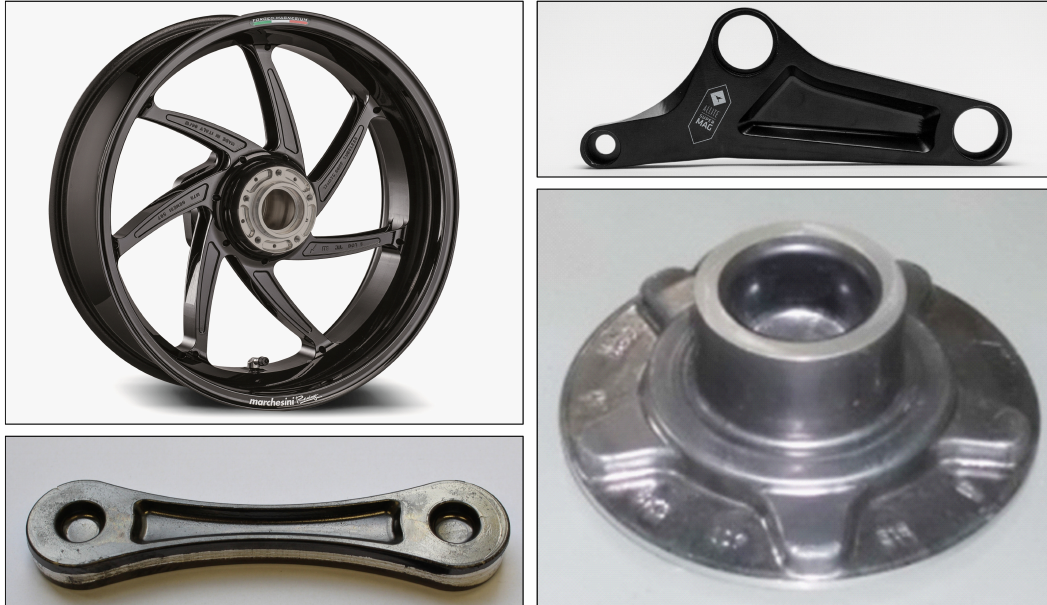
Figure 1. Various Mg forged parts, showing (u.l.) a motorbike rim produced by BremboS.p.A. under Marchesini trademark, (u.r.) a bike suspension link made by ALLITE R (cid:13) Inc., (b.l.) laboratory scale piston rod forged by Light Metals Technologies Ranshofen and (b.r.) a wheel hub produced by Institut für Metallformung, University Freiberg. Reproduced with the kind permission of: BremboS.p.A., ALLITE R (cid:13) Inc., Light Metals Technologies Ranshofen and TU Bergakademie